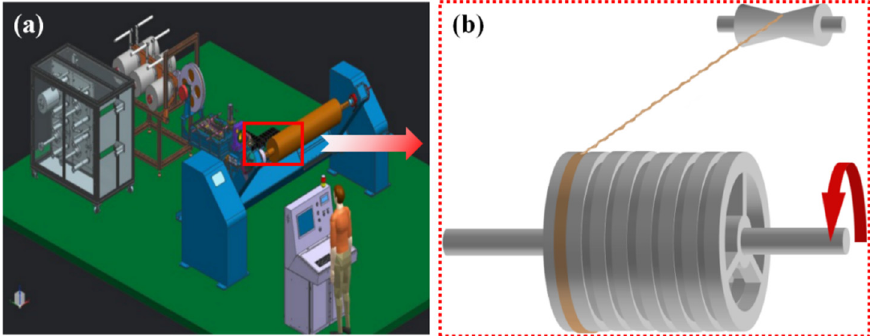
Figure 2. NOL ring preparation: ( a ) winding process schematic; ( b ) NOL ring winding.